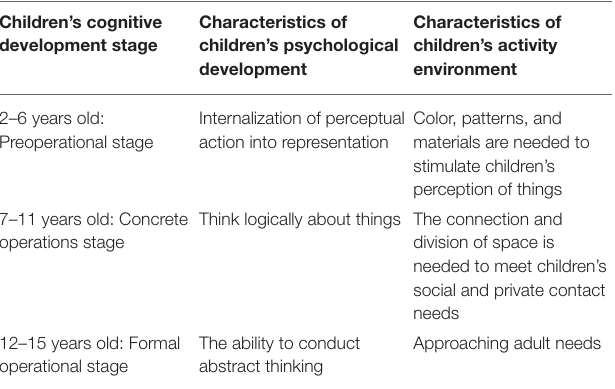
TABLE 1 | Characteristics of children’s psychological development and their environmental